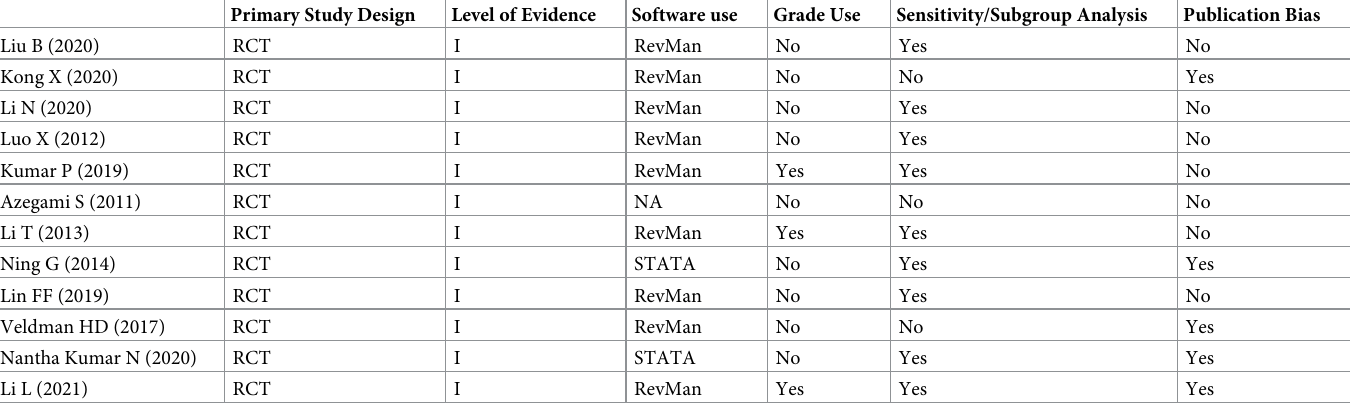
Table 4. Methodologic